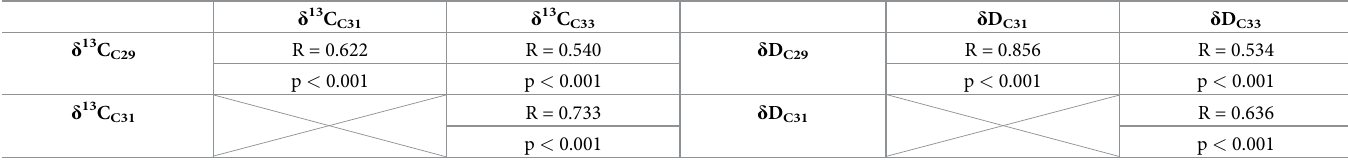
Table 2. Correlation of carbon and hydrogen isotopic data from